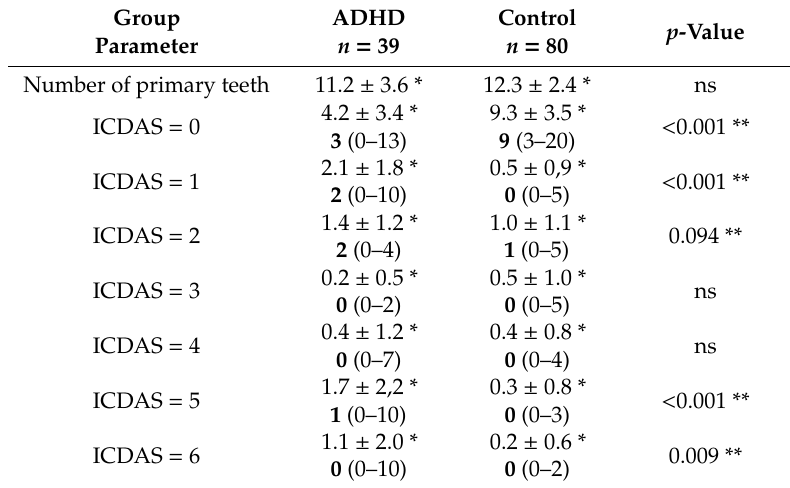
Table3. StatisticalanalysisforprimarydentitionaccordingtoICDASscoreinADHDandcontrolgroups.